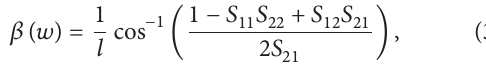
Figure 2: Equivalent circuit of the SMTL unit